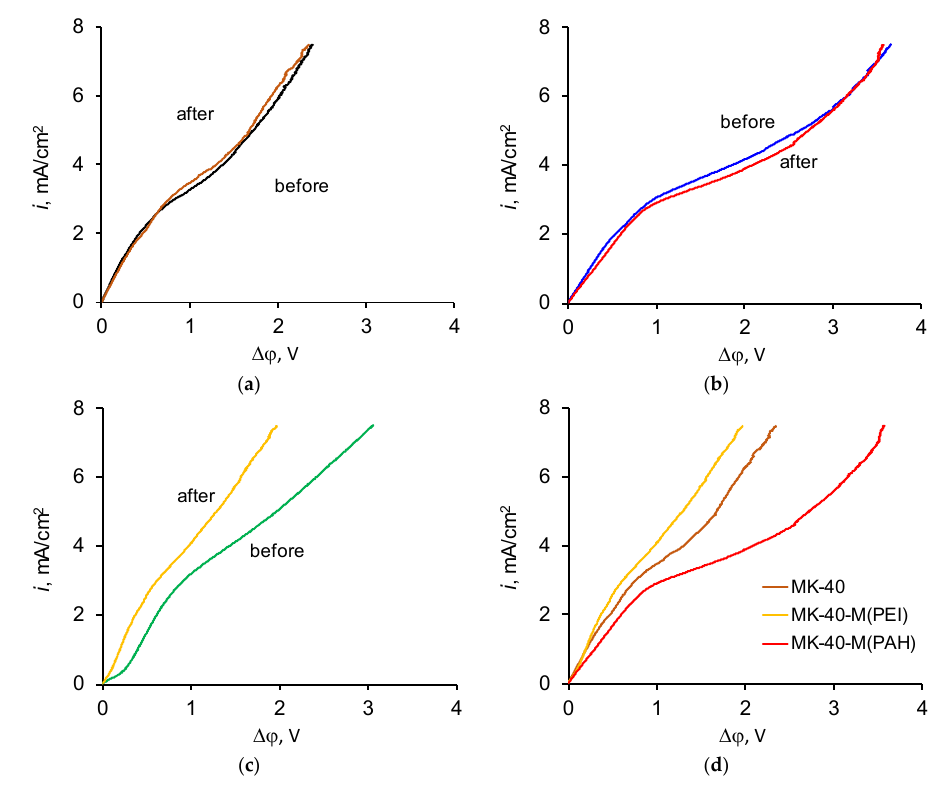
Figure 7. Pair ‐ wise comparison of the i ‐ V curves recorded before and after electrodialysis with ( a ) Figure 7. Pair-wise comparison of the i-V curves recorded before and after electrodialysis with MK ‐ 40, ( b ) MK ‐ 40 ‐ M (PAH), ( c ) MK ‐ 40 ‐ M (PEI) membranes, as well as comparison of the i ‐ V curves of all studied membranes after electrodialysis ( d ). ( a ) MK-40, ( b ) MK-40-M (PAH), ( c ) MK-40-M (PEI) membranes, as well as comparison of the i-V curves of all studied membranes after electrodialysis ( d